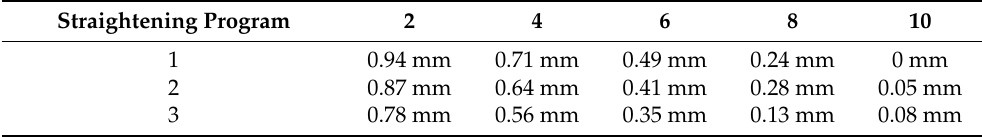
Figure 14. The morphology curve with different straightening projects. In Figure 14, the interface morphology was affected by straightening process param- eters. In particular, the amplitude and period length gradually decreased with the reduc-